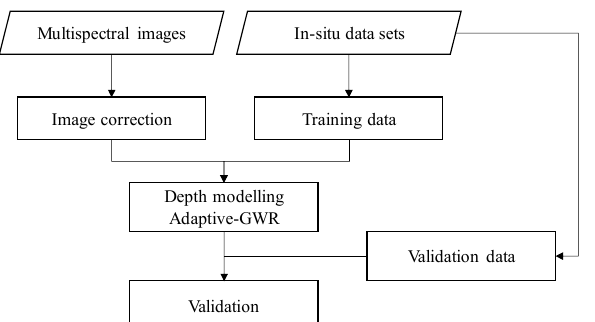
Figure 1. General workflow of this study.